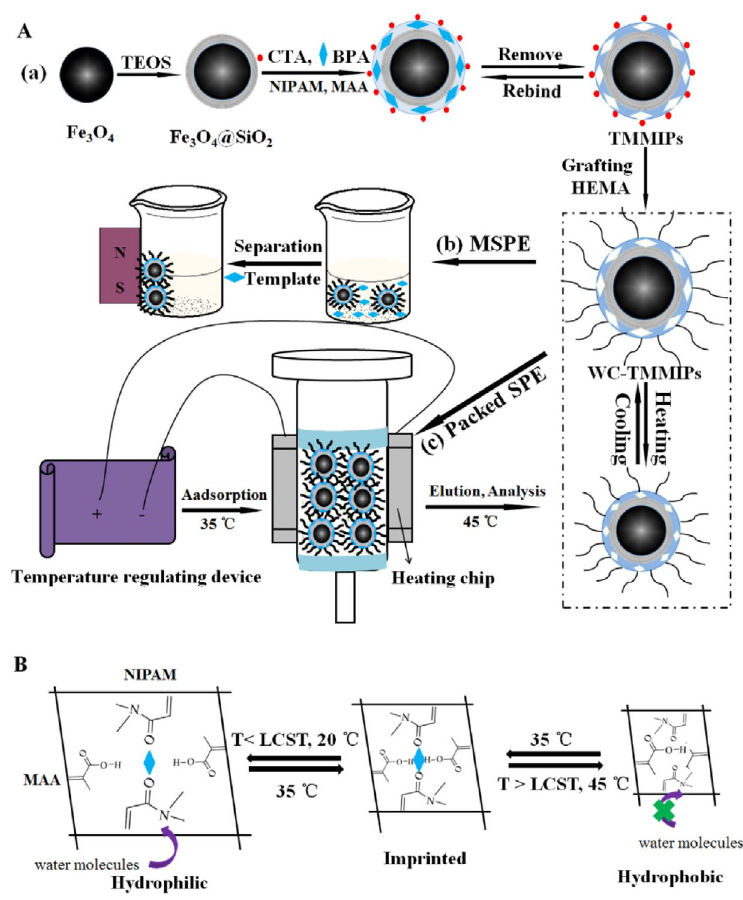
Fig. 11. (A) Schematic illustrations of the preparation process and temperature-regulated shrinking/swelling behavior (in the dotted box) of WC-TMMIPs (a), and their applications to MSPE (b) and packed SPE (c). (B) Schematic representation of the adsorption and release process of BPA by the WC-TMMIPs and possible molecular recognition mechanism regulated by temperatures [94].